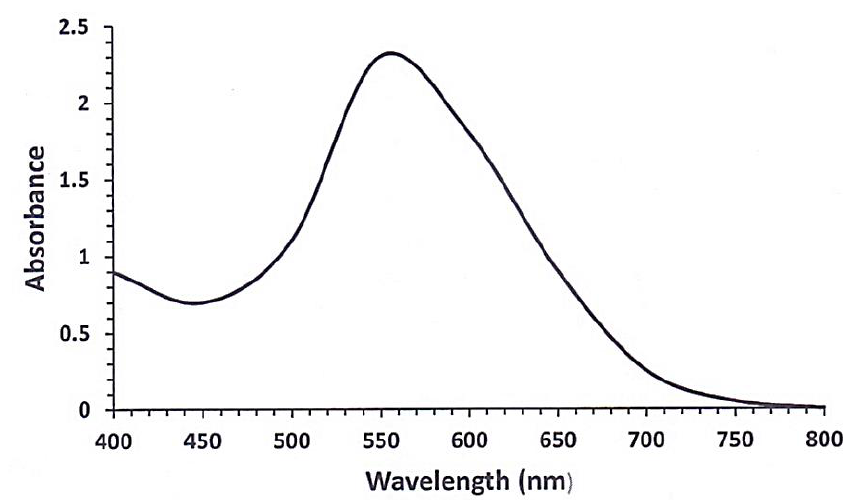
Figure 2. Visible spectrum of TA-mediated Figure 2 . Visible spectrum of TA-mediated CuNPs.